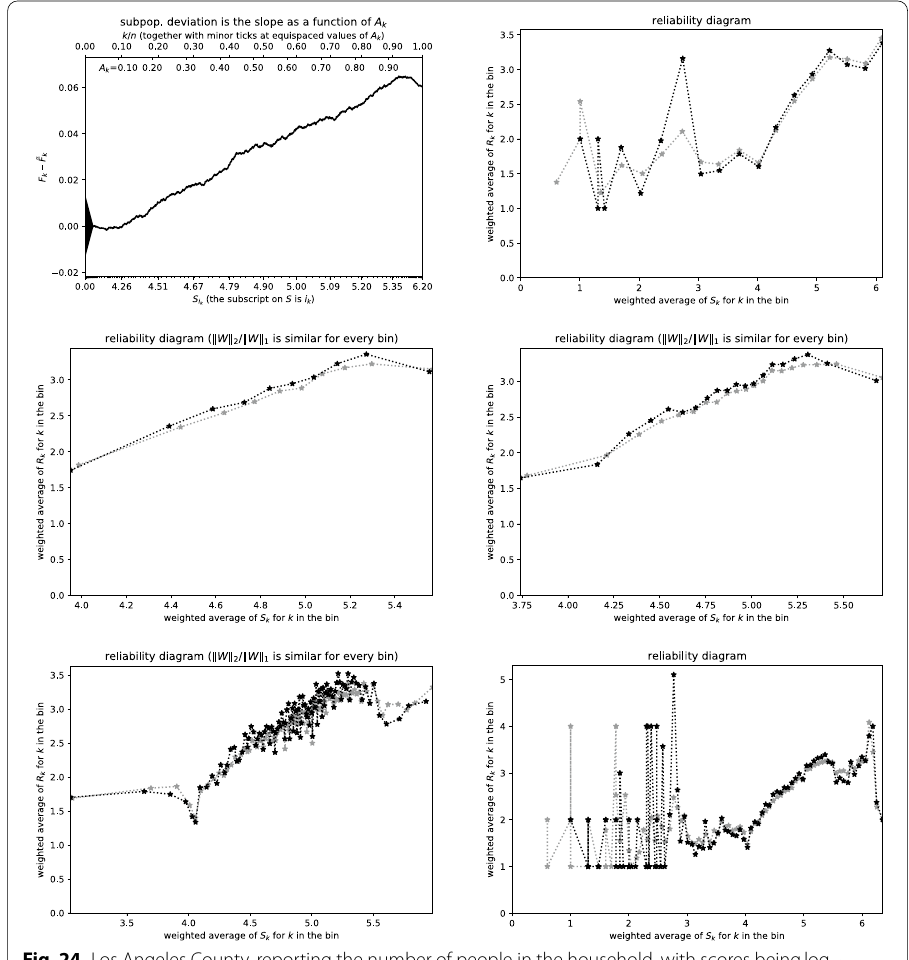
Fig. 24 Los Angeles County, reporting the number of people in the household, with scores being log 10 of the adjusted household income; n = 35,364; Kuiper’s statistic is 0.06674 /σ = 9.605 , Kolmogorov’s and Smirnov’s is 0.06495 /σ = 9.347 . Discerning the analogue of the dip in the plot of cumulative differences at the highest scores is possible yet difficult in the reliability diagrams, while being unmistakable in the cumulative plot; the reliability diagrams with enough bins do reflect the corresponding deviation at the highest scores, but are hard to interpret without the accompanying cumulative plot. The scalar summary statistics report very highly statistically significant deviation, largely since the number of observations from this largest county in California is so